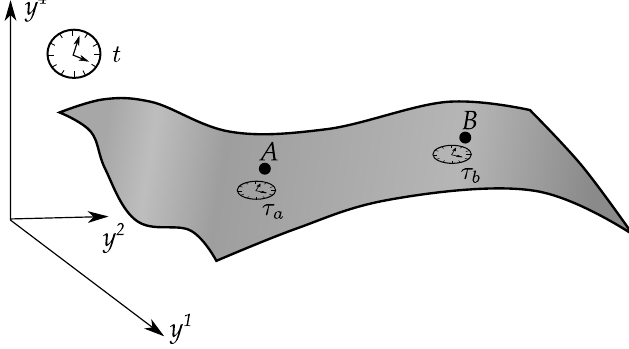
Fig. 1. Stationary observers A and B located within the cosmic fabric and measuring proper times (cid:1) a and (cid:1) b , respectively. The fabric is considered immersed in a four-dimensional hyperspace (not necessarily physical) with coordinates ð t ; y 1 ; y 2 ; y 3 ; y 4 Þ . The third spatial dimension is suppressed for